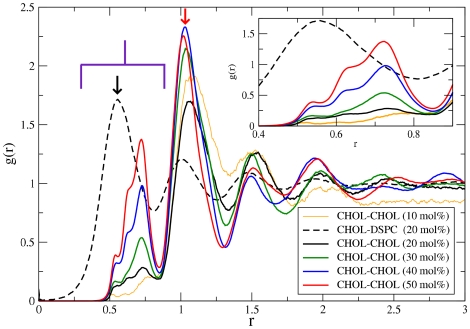
Radial distribution of lipids and cholesterol around cholesterol molecules.Pair correlation functions, g(r), for Chol-Chol (solid) and Chol-DSPC (dashed) pairs in the simulated DSPC/Chol membranes at different Chol concentrations. The color code indicates the cholesterol content: 10 mol% (yellow), 20 mol% (black), 30 mol% (green), 40 mol% (blue) and 50 mol% (red). Data for Chol-DSPC pairs is only provided for the system with 20 mol% of Chol. The radial distance from the center of mass of a Chol molecule is denoted by r. The inset shows a magnification of the first coordination shell. For Chol-Chol, the peak increases with increasing Chol concentration. The shapes of Chol-Chol peaks at high concentrations clearly show that they are composed of 3 overlapping peaks with maxima at approximately 0.45, 0.65 and 0.73 nm.